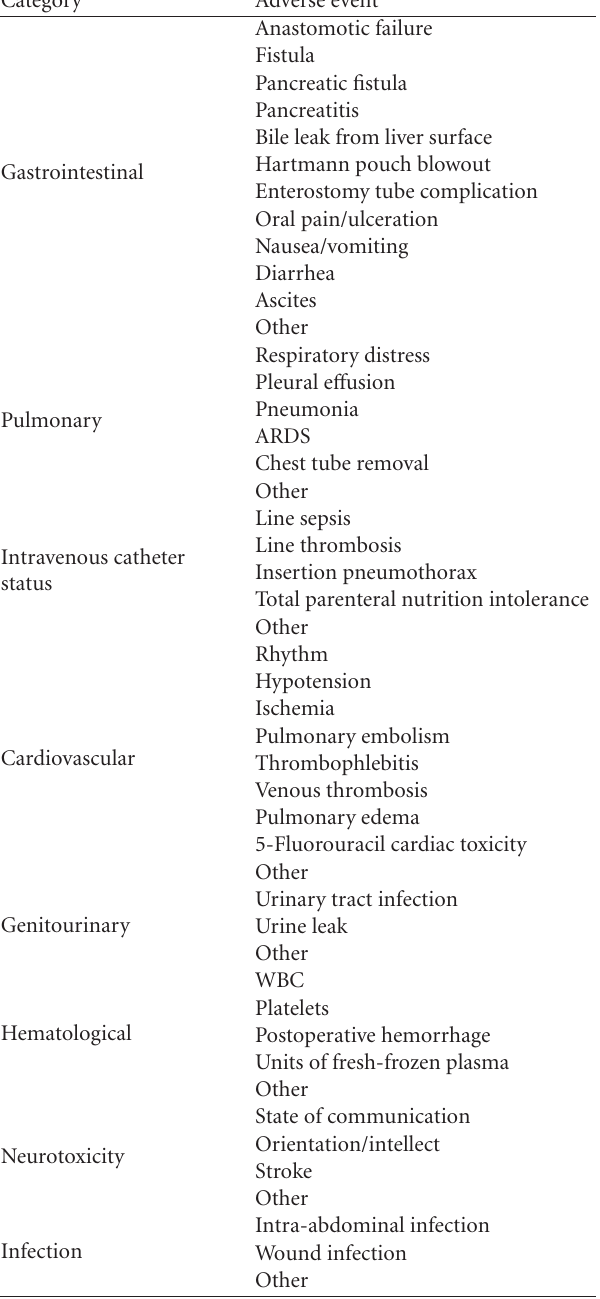
Table 1: Postoperative morbidity-mortality database in patients with peritoneal surface malignancy treated by cytoreductive surgery, hyperthermic intraperitoneal cisplatin and doxorubicin, and simul- taneous intravenous ifosfamide. Eight categories of events and 47 adverse outcomes were scored.